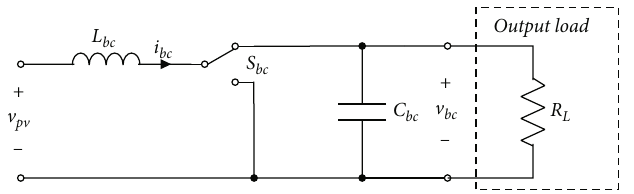
Figure 2: A DC-DC boost converter equivalent electric